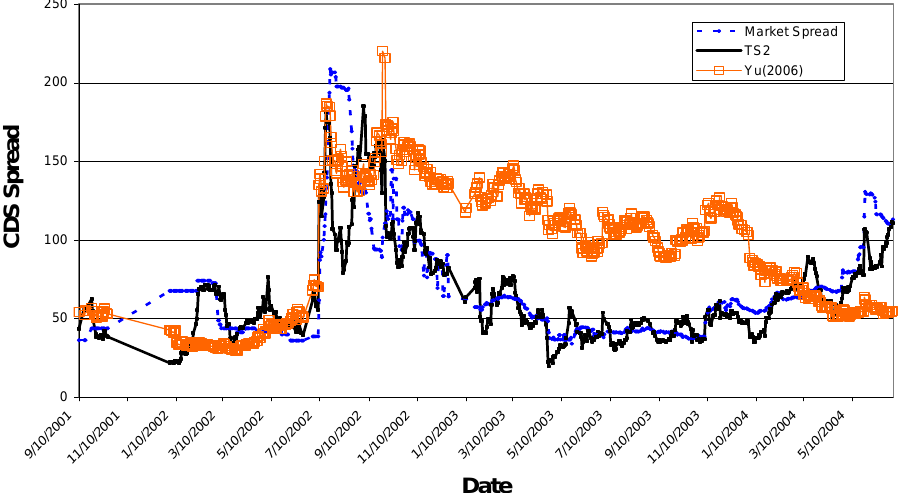
Figure 6. Wyeth CDS spread, TS2 vs. Yu [27]. Figure 6 compares the modeled CDS spreads computed by TS2 and those computed with methods of Yu [27]. As shown above, TS2 has a much tighter fit than Yu [27]. Yu [27] persistently over estimates market spread for an extended period from 30 August 2002 to 3 March 2004. In the middle, the fitting is far off.